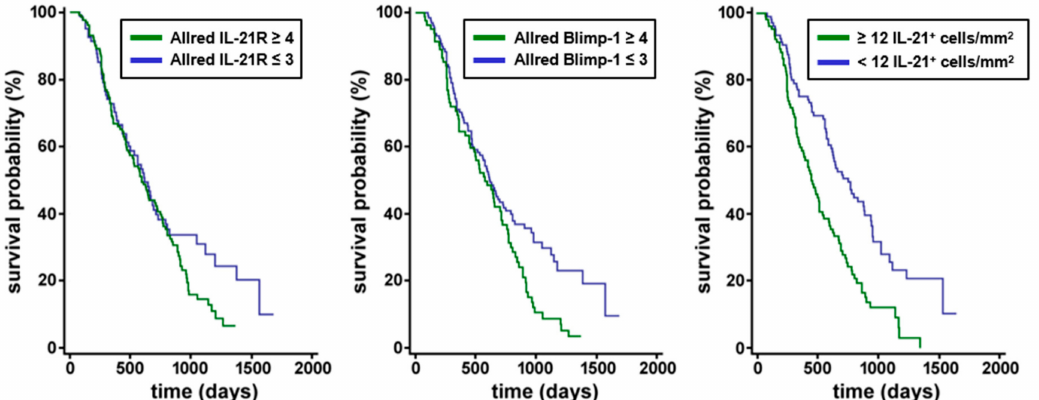
Figure 2. Correlation of IL-21 receptor with Blimp-1 expression and e ff ect on overall survival in human PDAC biopsies. Survival analysis of IL-21R and Blimp-1 expression. There was a non-significant trend towards shorter OS in PDAC patients with high IL-21R expression compared to patients with low IL-21R expression. PDAC patients expressing a high level of Blimp-1 had a significantly shorter survival compared to patients expressing a low level of Blimp-1. Survival was significantly shorter in patients with high IL-21 infiltrate compared to patients with low IL-21